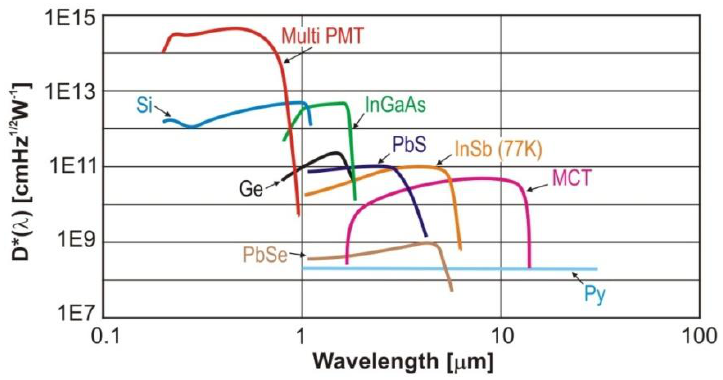
Figure 8. Example of photodetectors